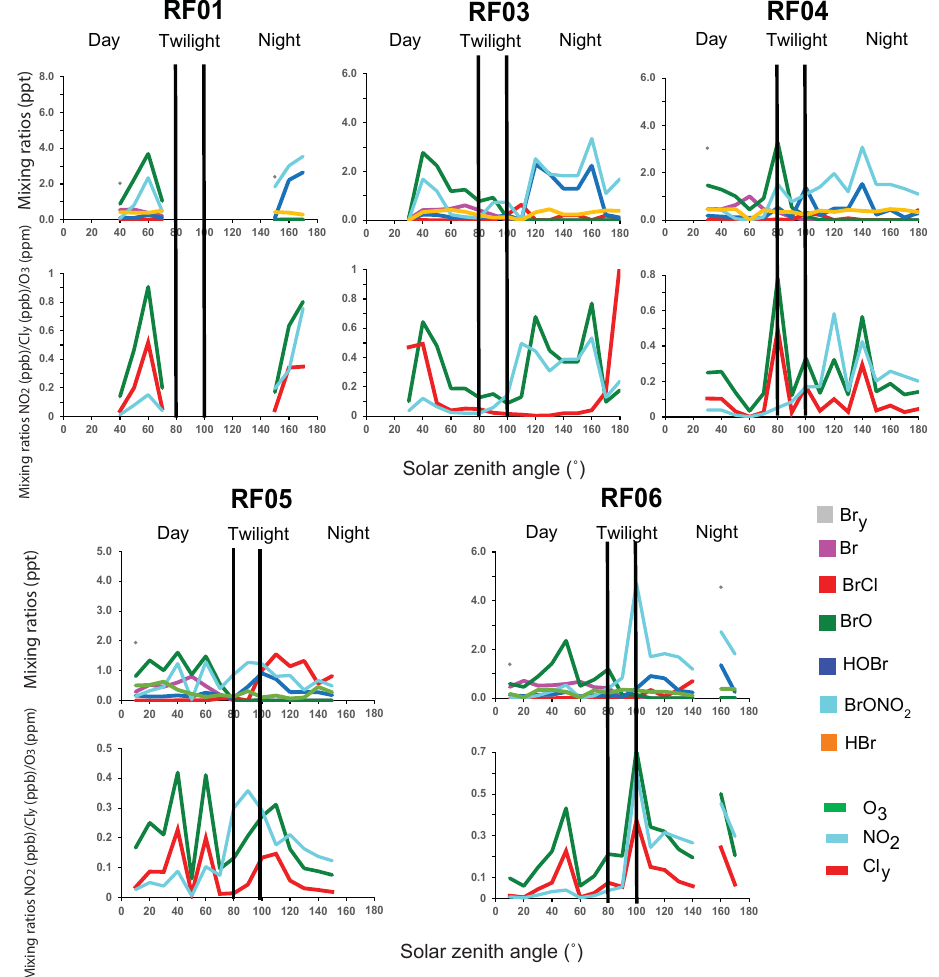
Figure 6. Inorganic bromine species and main reactants of the inorganic chemistry sampled at the same times and locations as the ATTREX flights over the eastern Pacific. Each separate panel show SZA dependent results for flights RF01, RF03, RF04, RF05 and RF06. Only output sampled between 14 and 18km is